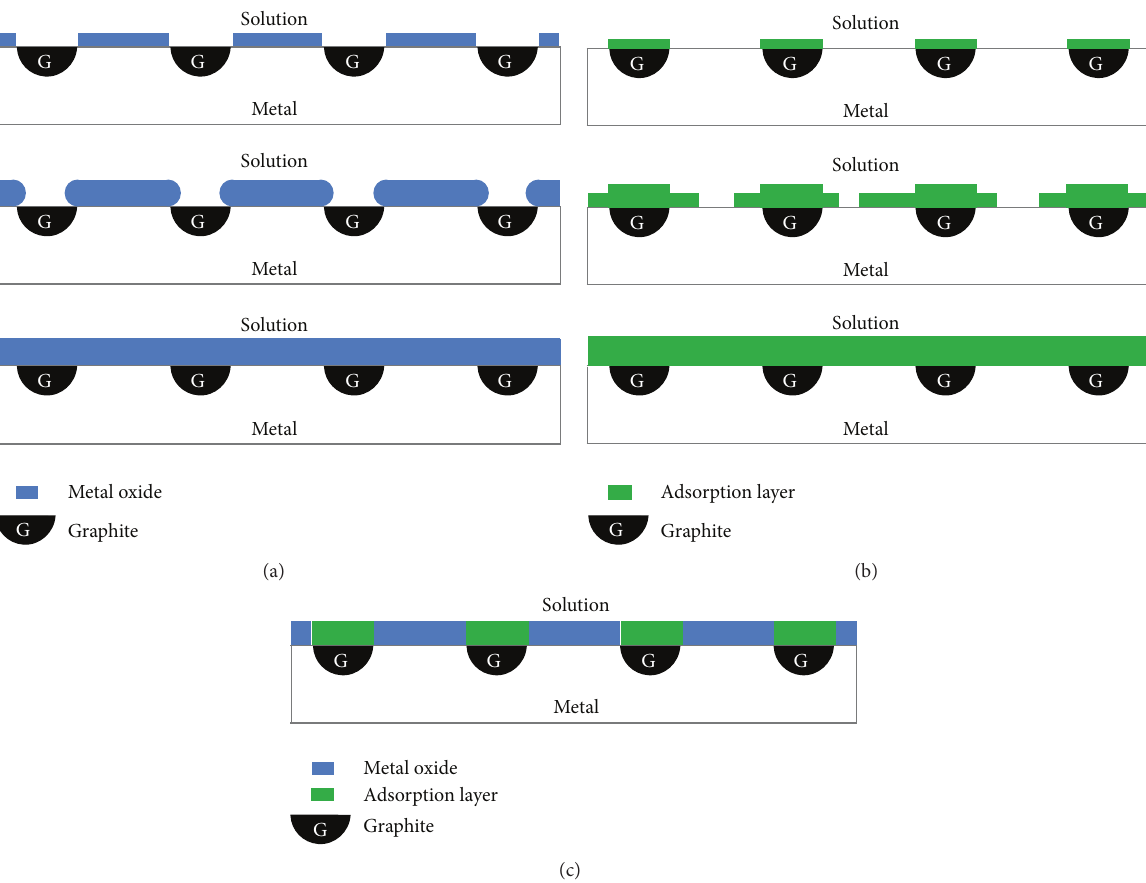
Figure 13: Newly proposed corrosion inhibiting mechanisms. (a) nitrite single addition [12], (b) TEA single addition, and (c) coaddition of nitrite +